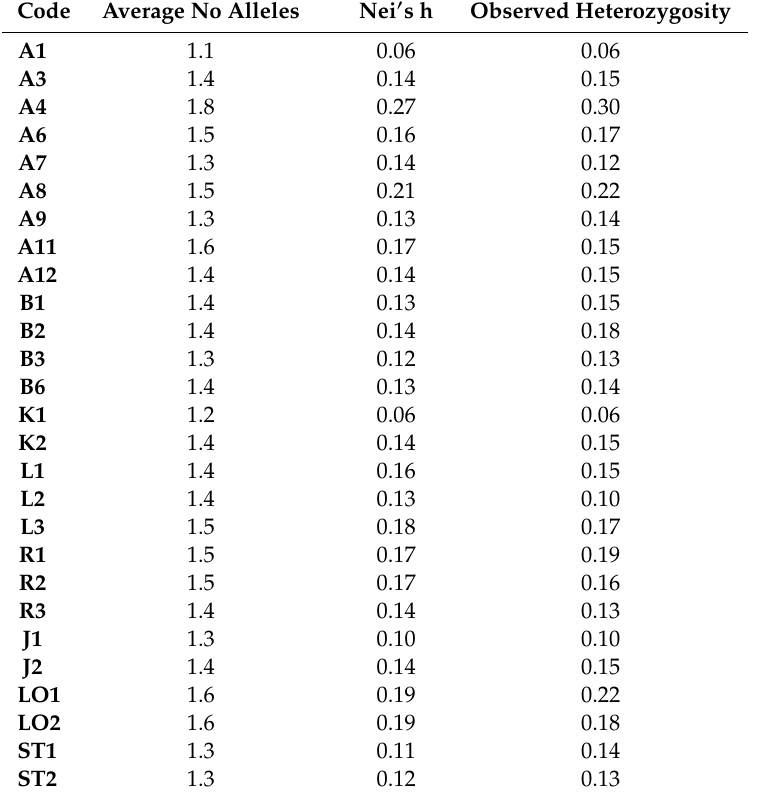
Table 2. Genetic diversity in individual accessions as measured by SNP